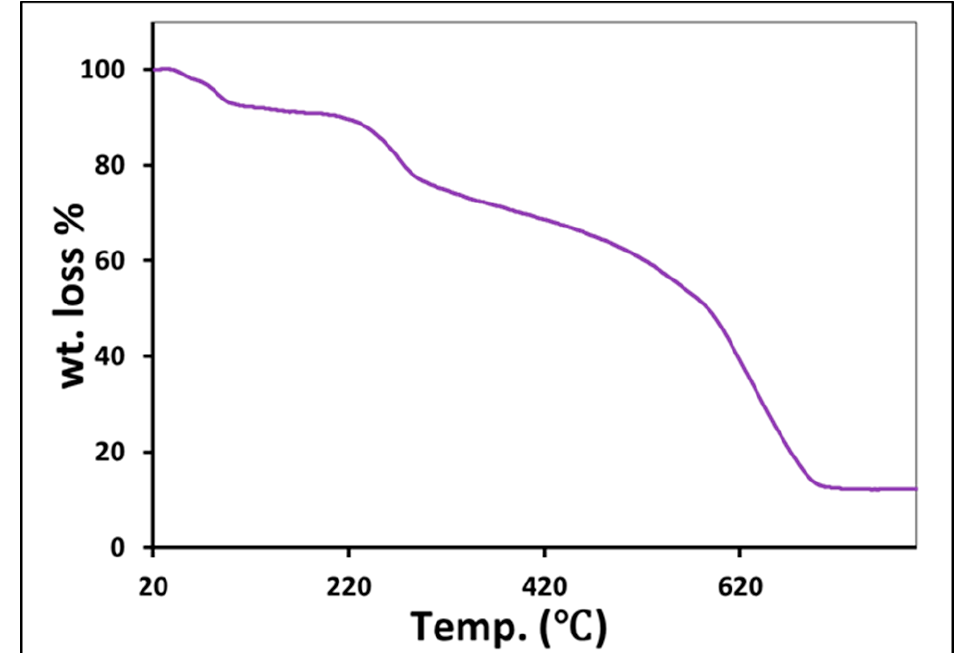
Figure 5. Thermogravimetric analysis (TGA) of complex 1.